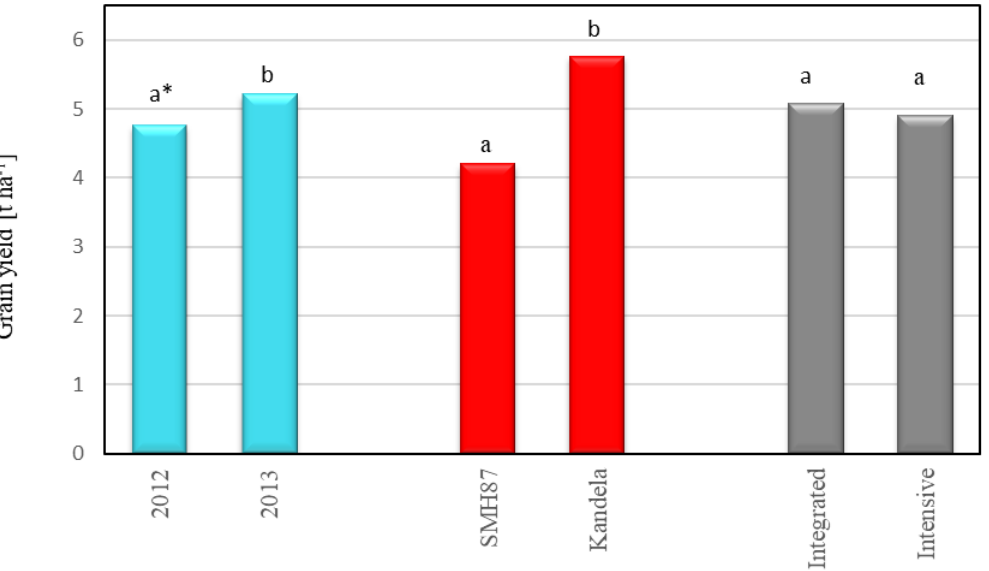
Figure 1. Wheat grain yield in relation to harvest year, cultivar and production technology. * Different letters (a, b) are significantly different (α = 0.05).